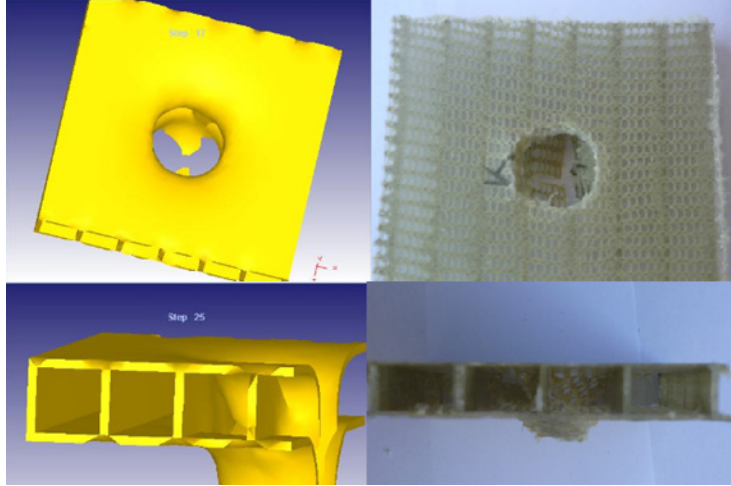
Figure 7. Comparison of the breaking area for the simulated model and impacted samples. The program provides information on the time frames for each deformation snapshot, and about the characteristics of the process in that moment (work speed, force deformation, the value of the impactor stroke, etc.), as illustrated in Table 4. Table 4. Extracted information obtained from finite element analysis.